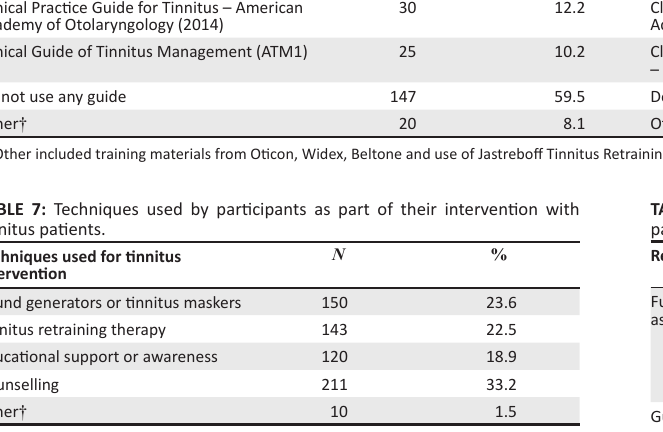
TABLE 6: Use of guidelines or policies for the assessment and intervention of tinnitus. Use of guidelines or policies for assessment of tinnitus